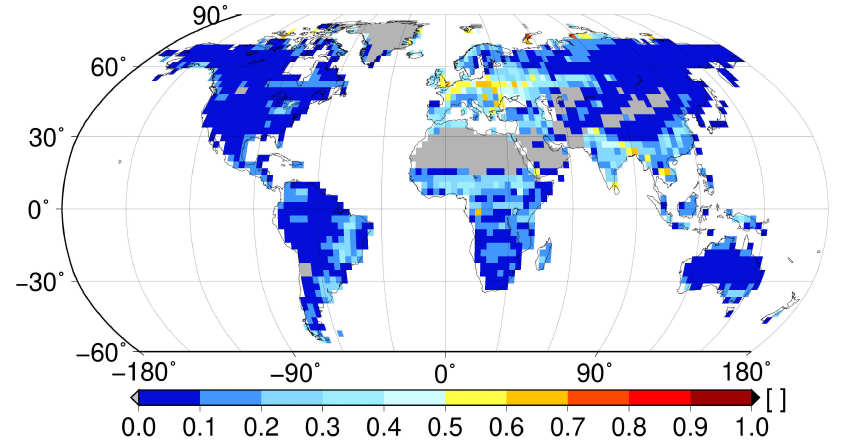
Figure 4. Fraction of time which non-vascular epiphytes spend near saturation (95%–100% of saturation) simulated by the LiBry model. Grey areas denote regions, where no non-vascular epiphytes occur according to the model.